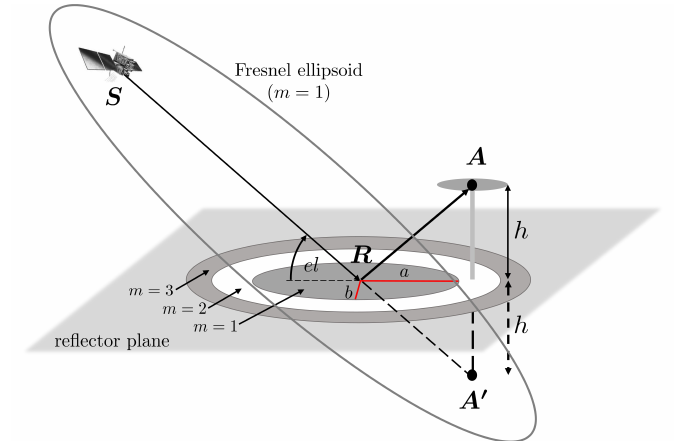
Figure 5. Intersection of Fresnel ellipsoid of the first order with the horizontal reflector plane. Between the satellite S and the mirrored antenna point A (cid:48) , a number (orders m ) of ellipsoids of revolution can be formed, with S and A (cid:48) representing the respective focal points [37]. The Fresnel ellipsoid of first order defines the region where most of the energy is transmitted. The intersection of the Fresnel ellipsoids and the reflector surface is called a Fresnel zone. In the case of a horizontal reflector, the size and shape depends on the satellite elevation angle el , the carrier wavelength λ and the vertical distance h between the antenna and the reflector. The semi-major and semi-minor axes of the first Fresnel zone are given